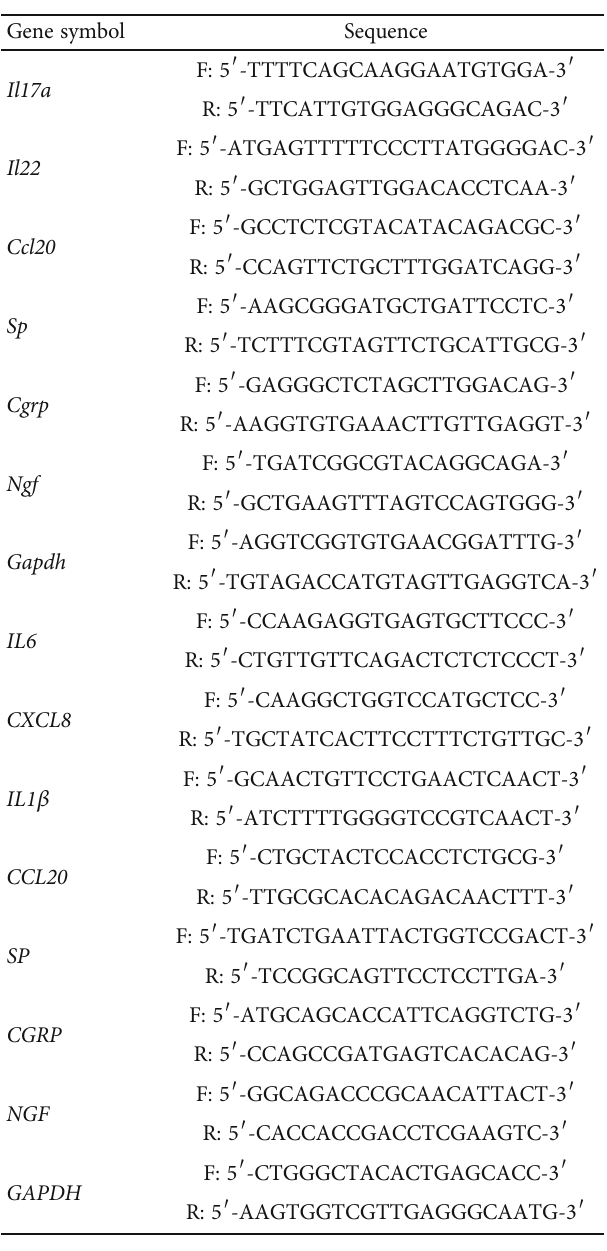
Table 1: Primer sequences for quantitative reverse-transcription polymerase chain